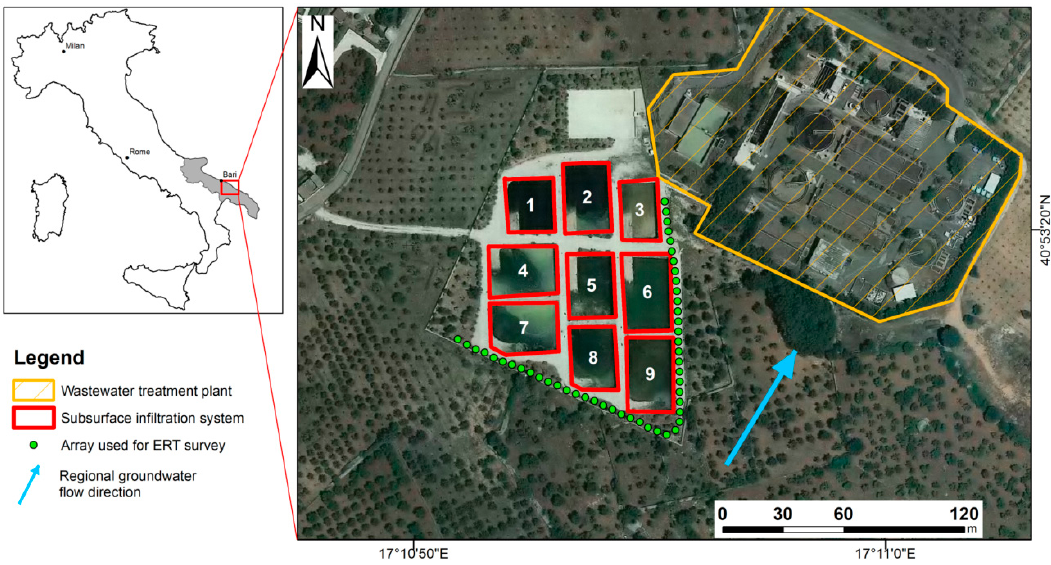
Figure 1. Location of the experimental site, including the infiltration trenches and the geophysical setup.